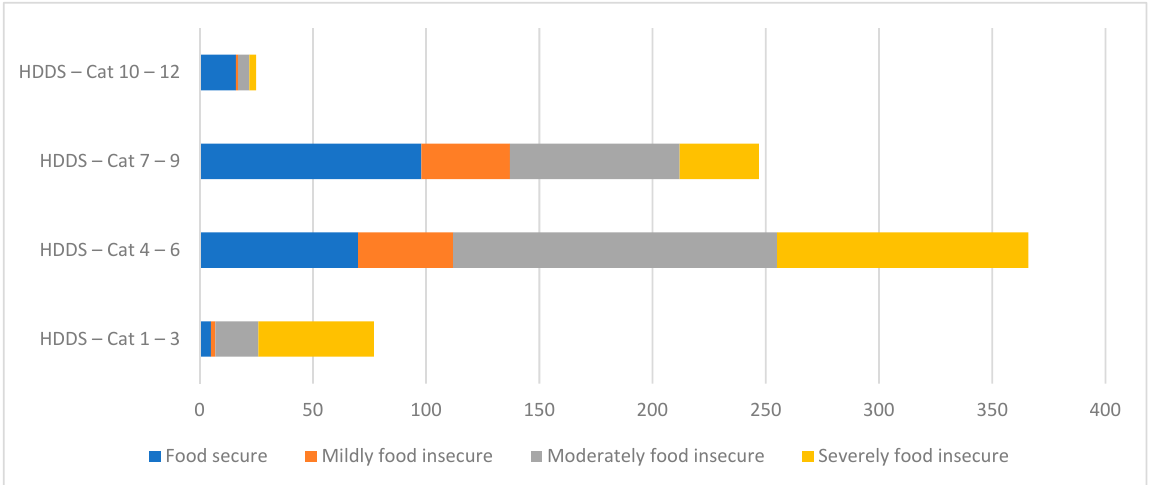
Figure 1. Relationship between household dietary diversity and food security. Notes: HDDS = Household Dietary Diversity Score; Cat = Category.